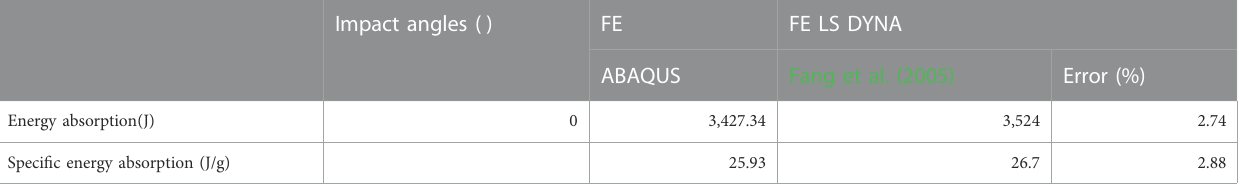
TABLE 3 Differences between FE LS DYNA and FE ABAQUS results (Jiang et al., 2010). Impact angles (